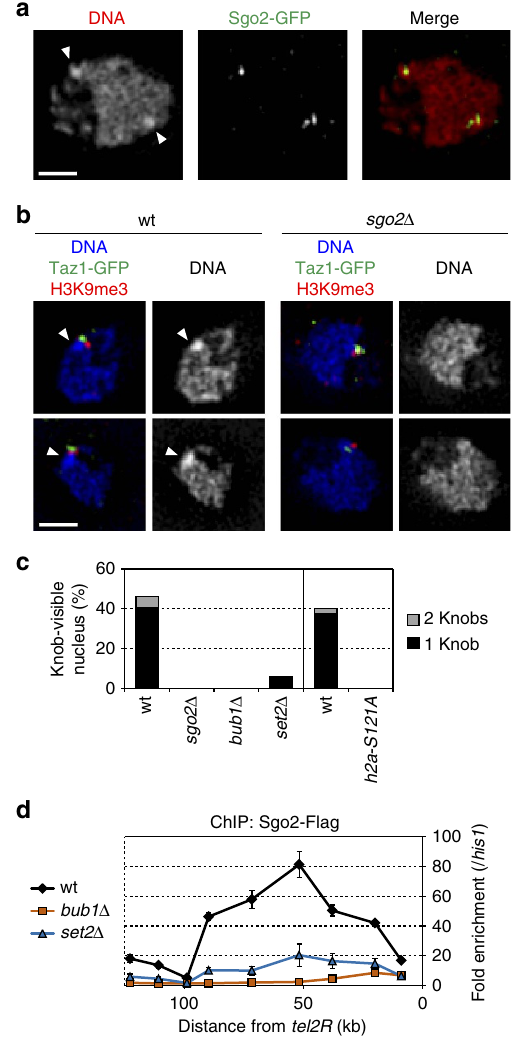
of Sgo2-GFP with knobs during interphase. Cells were grown in EMM at 26 (cid:2) C and then fixed in formaldehyde (see Methods). 3DSIM images of single optical sections for DAPI and Sgo2-GFP (from immunostaining using anti-GFP antibody) signals in an interphase cell are shown. Arrowheads indicate knobs with intense DAPI signals. Scale bar, 1 m m. ( b ) Knobs are localized near Taz1-GFP (telomere) and H3K9me3 (subtelomeric heterochromatin) in wt cells, but are absent in sgo2 D cells. 3DSIM images of single optical sections were taken as in a . Arrowheads indicate knobs. Scale bar, 1 m m. ( c ) Sgo2 association with subtelomeres is required for knob formation. Frequencies of knob formation in each strain during exponential growth are shown. ( d ) Sgo2 association with subtelomeres is substantially decreased in the absence of Set2. Sgo2-Flag localization at subtel2R in bub1 D and set2 D cells was analysed by ChIP. Relative fold enrichment at subtel2R , normalized to the signal at the his1 þ locus, is shown. Error bars indicate the s.d. ( n ¼